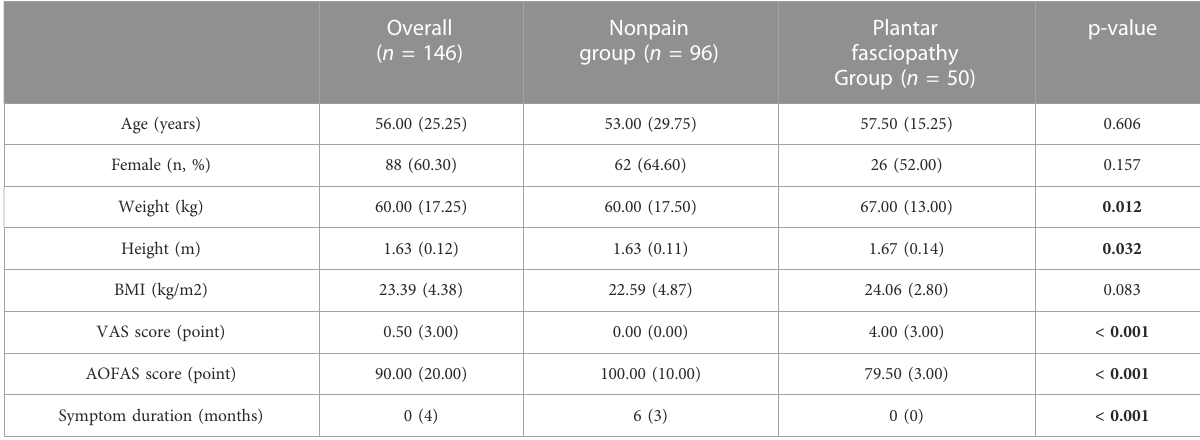
Data are presented as number (%) or median (Interquartile range). Bold font indicates a signi fi cant correlation ( p < 0.05). BMI, body mass index; VAS, visual analogue scale; AOFAS, American Orthopedic Foot and Ankle Society score.